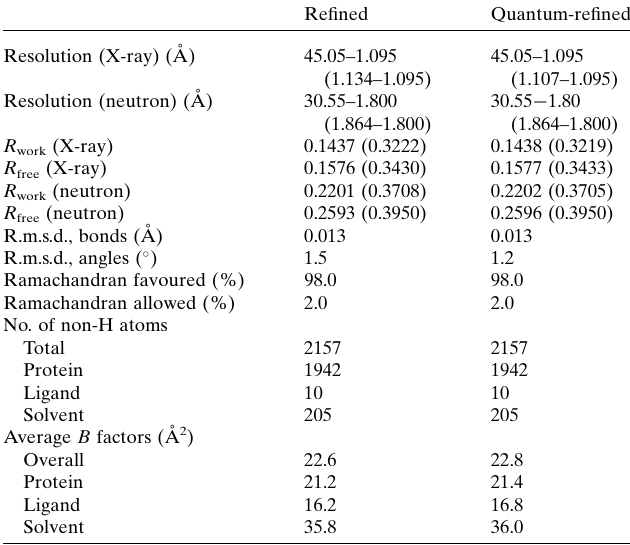
Table 2 Refinement statistics of the refined (PDB entry 7az9) and quantum- refined (PDB entry 7aza) structures of